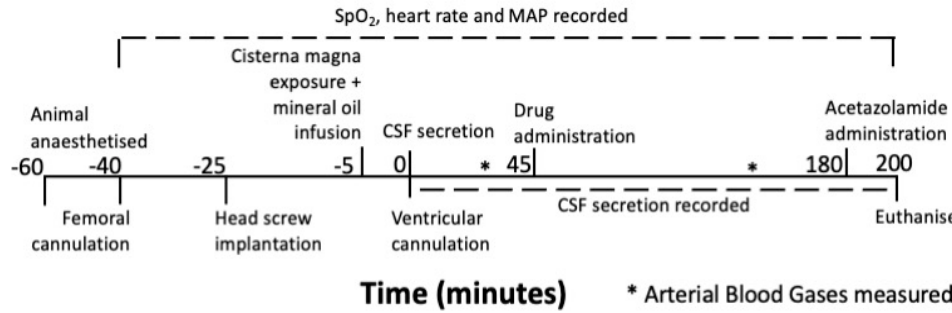
Figure 1. Experimental timeline. Oxygen saturation (SpO 2 ), heart rate, and mean arterial pressure (MAP) were recorded from − 40 to 200 min. CSF secretion was recorded from 0 to 200 min after mineral oil infusion via cisterna magna and ventricular cannulation. Bumetanide, RN1734, or DMSO was administered at 45 min and acetazolamide administered at 180 min. Recording was ceased at 200 min and the animal was euthanised. * Arterial Blood Gases were measured at 30 and 150 min.